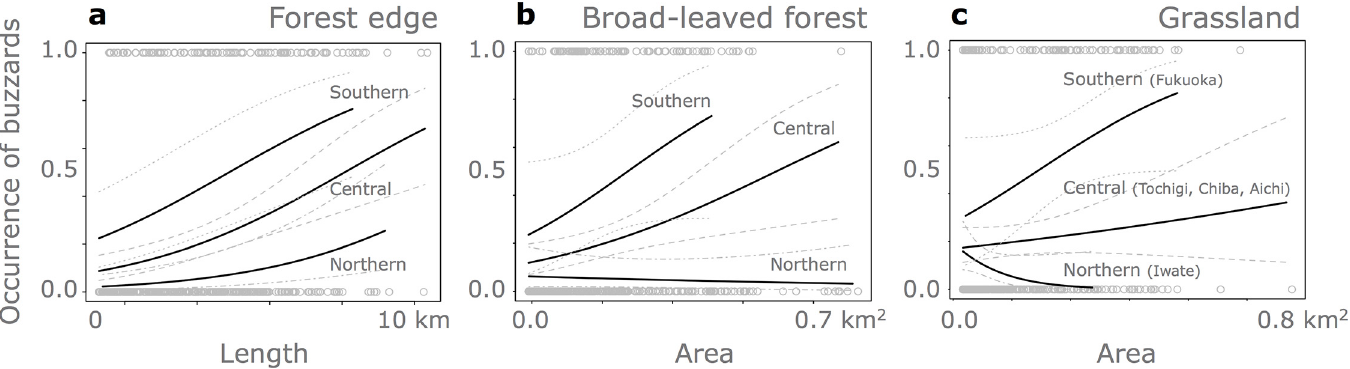
Fig 5. Relationships between buzzard occurrence and landscape elements (forest-edge, broad-leaved forests, and grasslands) in 1 km x 1 km cells inferred by the selected models for the three geographical-regions hypothesis. Solid lines show inferred relationships. Dotted, dashed, and chain lines represent 95% confidence intervals for the relationships in southern, central, and northern regions, respectively. Open circles are observed values.